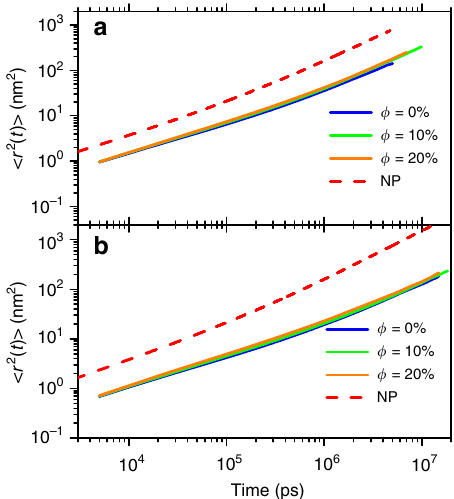
Fig. 2 Solid lines are the MSD of linear matrix PS chains in the composites of a PS500/NP250 and b PS1300/NP250 with different loadings ( ϕ ) of NP250. The MSD for the CM of NPs are plotted as references (dash line).